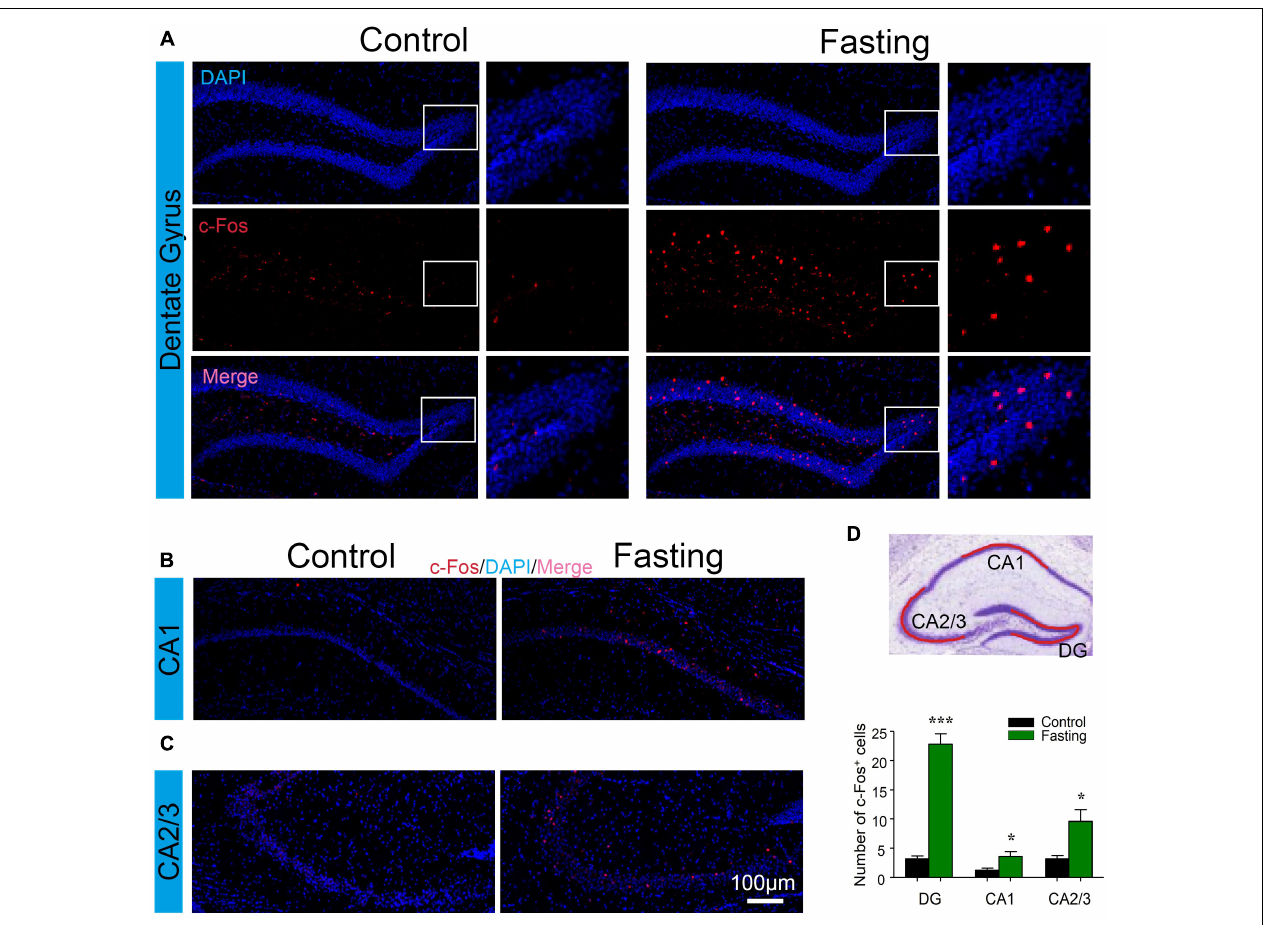
FIGURE 5 | Acute fasting increases the c-Fos expression in different sub-hippocampal areas. (A–C) Representative photomicrographs of c-Fos immunostaining in the dentate gyrus (DG), CA1, and CA2/3. There were a higher number of c-Fos + cells in the fasting group (right panel) in comparison with the control group (left panel). Scale bars represent 100 µ m. (D) Schematic illustration of the hippocampus. The red line indicates the captured and analyzed sub-region of hippocampus including DG, CA1, and CA2/3 areas. The bar graph shows the number of c-Fos + cells in different hippocampal areas. Note that the number of c-Fos + cells was significantly increased following 9-h fasting as compared to the control condition. Data are shown as mean ± SEM (Student’s t -test; ∗ p < 0.05; ∗∗∗ p < 0.001; n = 4–6